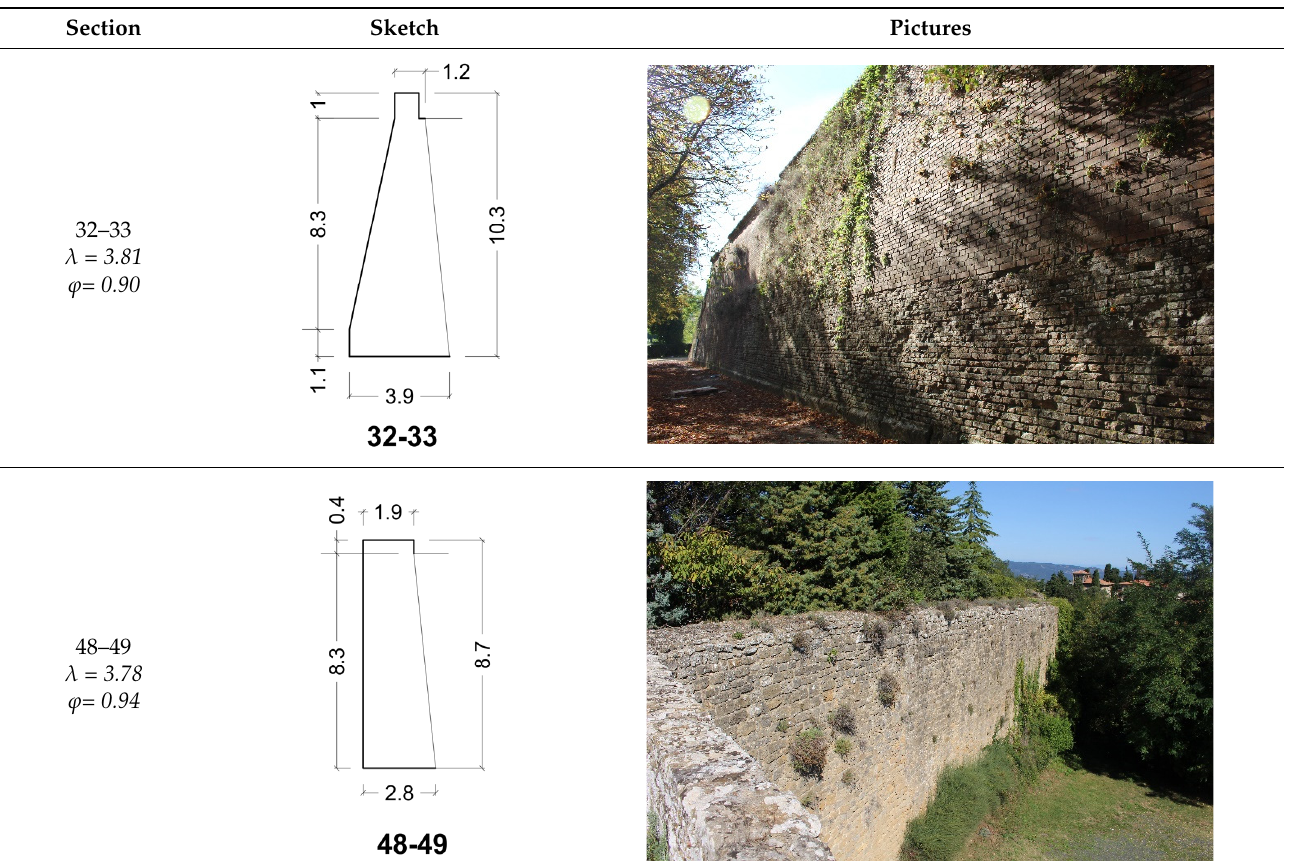
Figure 2. Perimeter of medieval walls of Volterra divided into numbered sections. Table 1. Volterra’s HUW analyzed sections. Geometry, slenderness λ , and filling ratio ϕ . Dimensions are in meters.